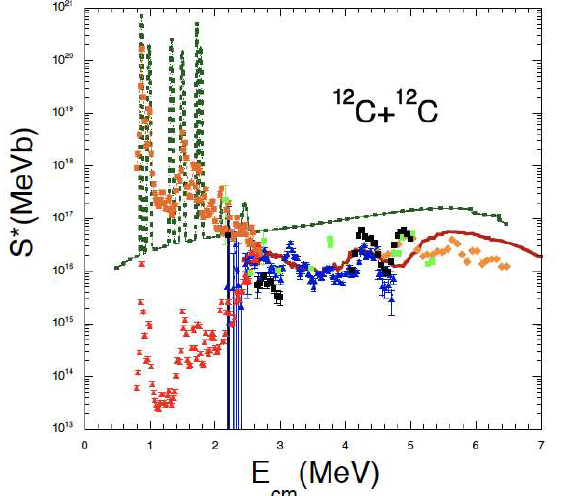
figure 1 that at the lowest